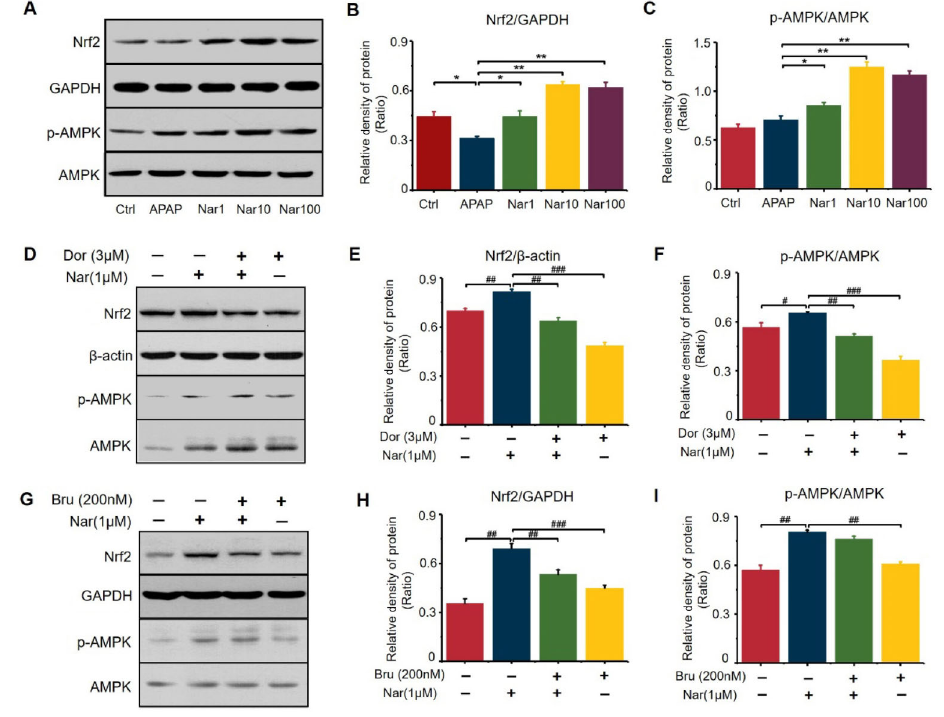
Figure 6. Naringin (Nar) activated AMPK/Nrf2 signaling in HepG2 cells. A , B , and C , Western-blot results of Nrf2 and pAMPK/AMPK expression. D , E , and F , HepG2 cells were treated with dorsomorphin (Dor) (3 m M) and Nar (1 m M) for 8 h, and proteins (Nrf2 and pAMPK/AMPK) were detected by western blotting. G , H , and I , HepG2 cells were treated with brusatol (Bru) (200 nM) and Nar (3 m M) for 8 h, and proteins were detected by western blotting. Data are reported as means ± SD (n=3). *P o 0.05, **P o 0.01 vs the APAP group. # P o 0.05, ## P o 0.01, and ### P o 0.001 compared with cells treated only with Nar